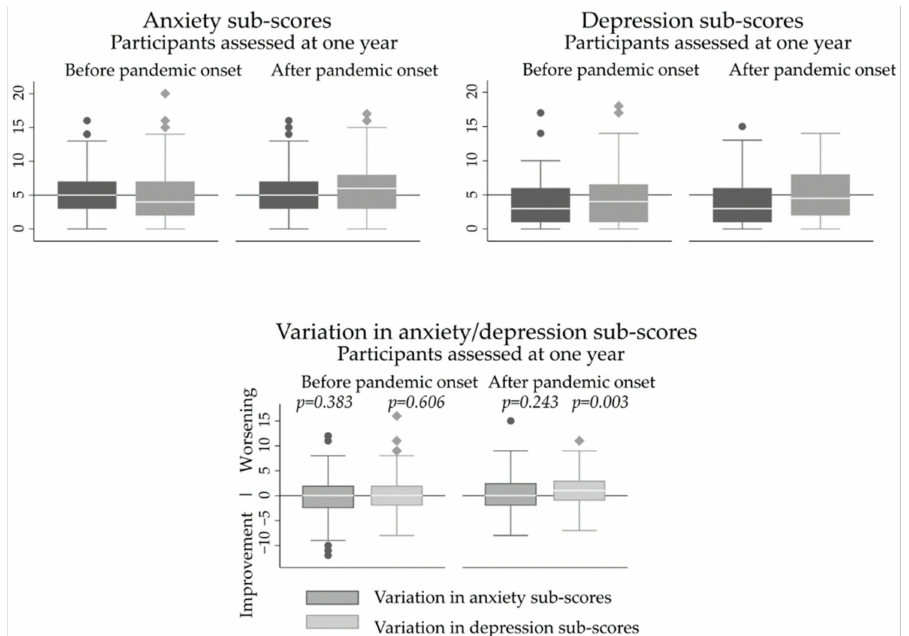
Figure 2. Distribution of anxiety and depression sub scores of the Hospital Anxiety and Depression Scale, at baseline and after one year, and of the variation in sub scores from baseline to the one-year evaluation, according to the period in which the one-year evaluation was performed (before or after the onset of COVID-19 pandemic). p values refer to testing the null hypothesis of the variation in scores being